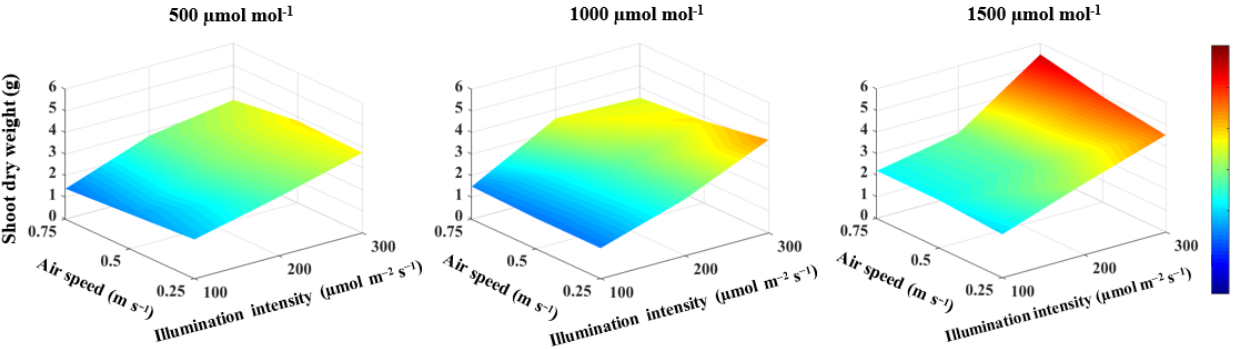
Figure 2. Effect of CO 2 concentration, illumination intensity and air speed on shoot dry weight of lettuce plants grown under artificial light. Table 2. Total leaf area, number of leaves and plant height of lettuce plants as affected by CO 2 con- centration, illumination intensity and air speed.